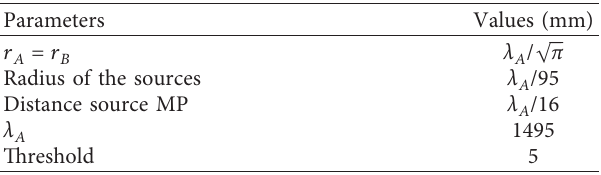
Figure 4: The flowchart of the proposed OTPA. Table 1: Parameters used in the numerical